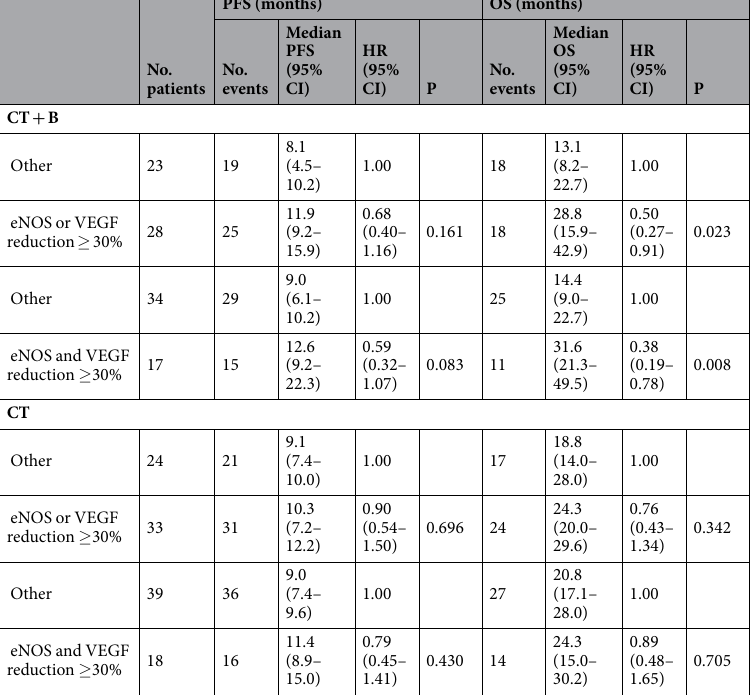
Table 3. Reduction in eNOS and/or VEGF levels with respect to PFS/OS. PFS, progression-free survival; OS, overall survival; HR, hazard ratio; CI, confidence interval; CT, chemotherapy; B,